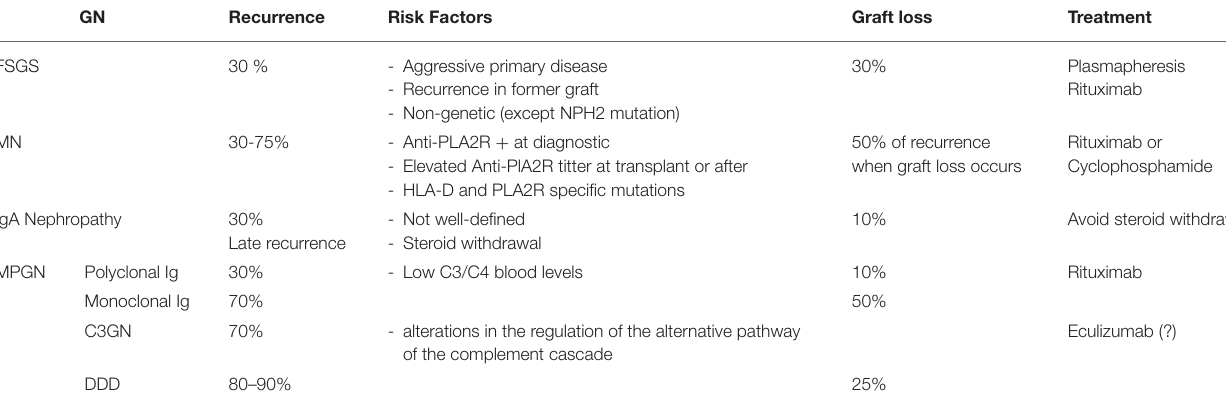
TABLE 2 | Recurrence profile of the main Glomerulonephritis (GN). GN Recurrence Risk Factors Graft